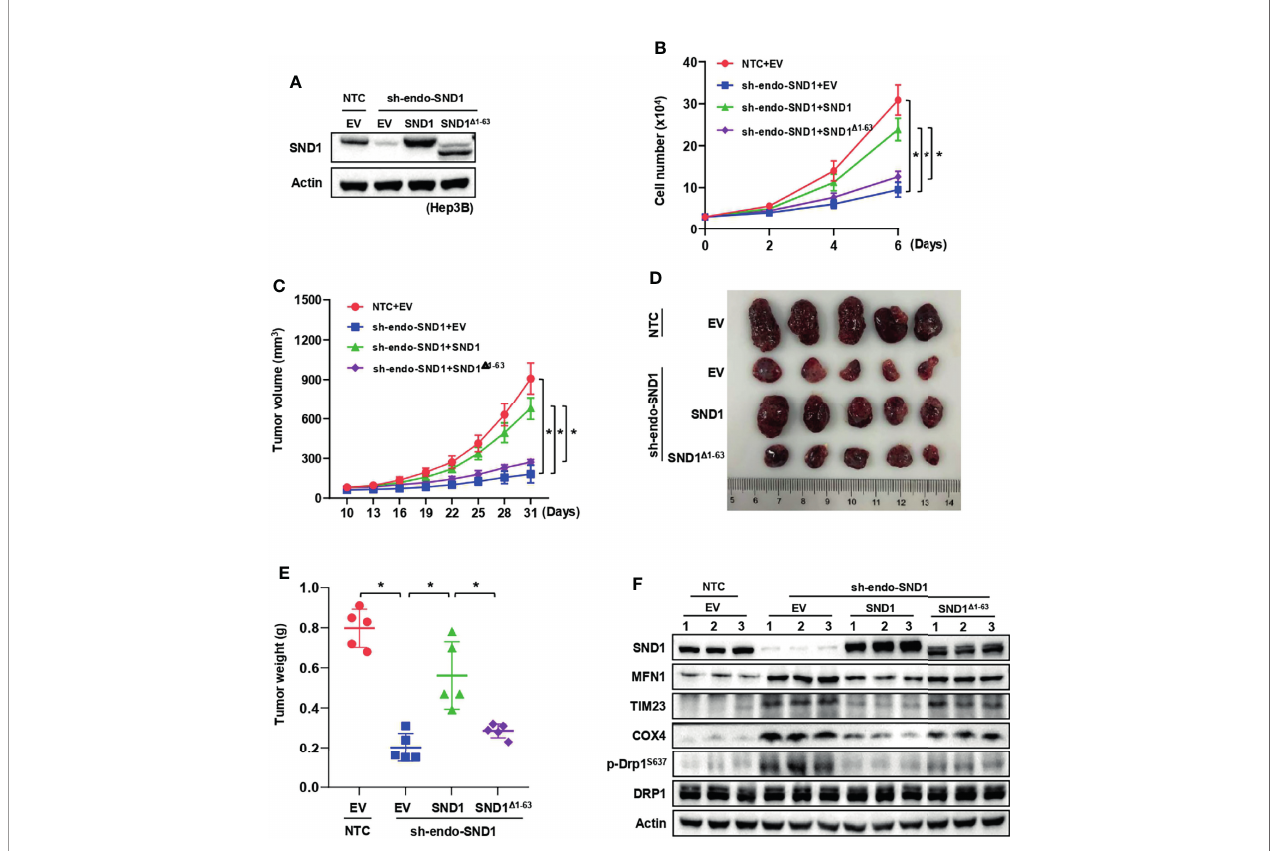
FIGURE 7 | Mitochondrial localization is required for SND1-mediated cell proliferation and tumor growth. (A, B) Growth curves of Hep3B cells with endogenous SND1 knockdown that were expressing Flag-EV, Flag-SND1, or Flag-SND1 D 1-63 were determined by trypan blue counting. Data are presented as the mean ± SD of three independent experiments. * P < 0.05 comparing the indicated samples. (C – E) Equal numbers of Hep3B cells mentioned in panel (A) were injected subcutaneously into the fl anks of BALB/c nude mice (n = 5 mice in each group). Tumor sizes were measured every 3 days using calipers (C) . Photographs show xenografts (D) , and tumor weights (E) were determined at the end of the experiment (Day 31). Data are presented as the mean ± SD, * P < 0.05 comparing the indicated groups. (F) Protein levels of SND1, MFN1, TIM23, COX4, p-DRP1 S637 , and DRP1 in tumor lysates of panel (D) were measured by immunoblotting analysis. Actin served as loading